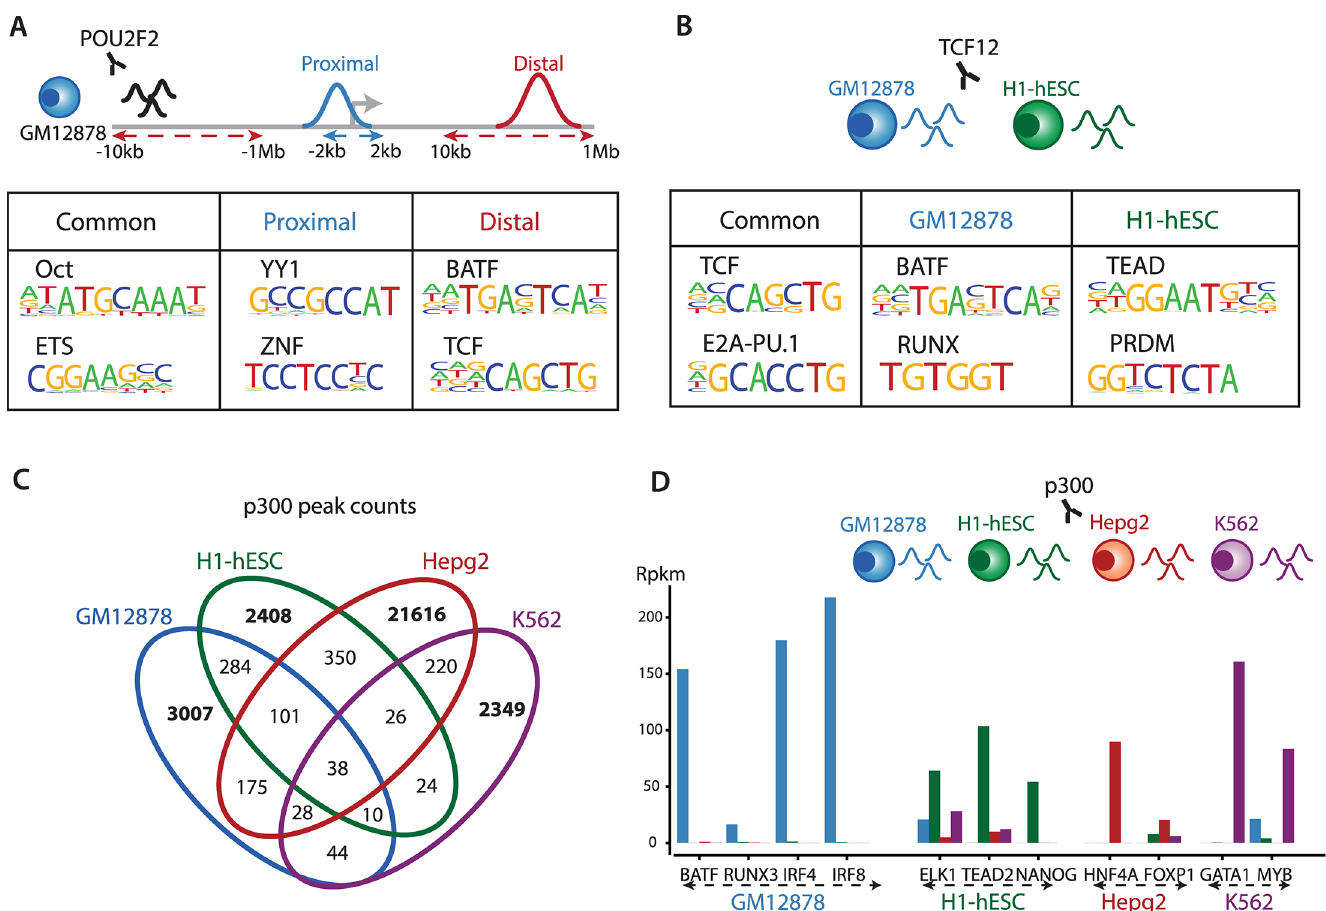
Fig 4. Candidate binding partners for a transcription factor are dependent on genomic context, cell type, and expression levels of partners. (A) Multitask learning identifies different candidate binding partners of POU2F2 at proximal and distal locations to genes. The proximal partners are associated with factors that preferentially bind to CG-rich motifs whereas the distal partners are associated with cell-type specific regulators. As expected, the POU/ octamer motif is present in both contexts. (B) Similarly, TCF12 binding profiles in GM12878 and H1-hESC shows preference for cell-type specific regulators at the cell-type specific sites, and the TCF motif is associated with peaks of both cell types. (C-D) The enhancer bound factor p300 shows highly cell-type specific binding and predicted TF signals. The cell-type specific expression of the p300 candidate binding partners partially explains the differing binding profiles of p300 across cell